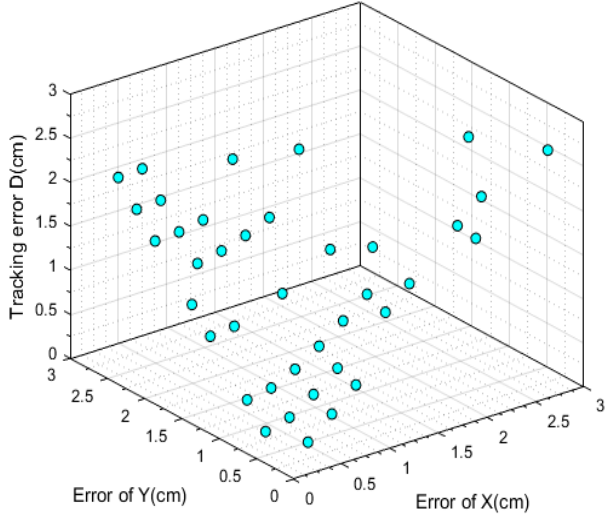
Figure 19. The error under the circumstance where nearly 50 percent of the LED’s area was shielded.